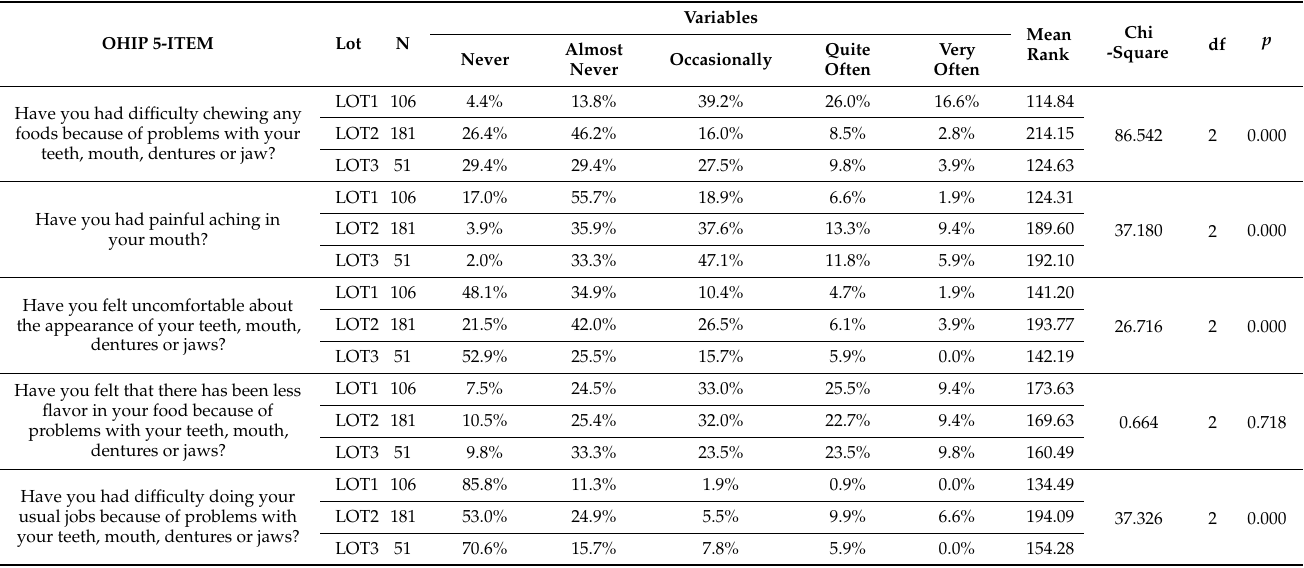
Table 3. Patients’ satisfaction with RPD